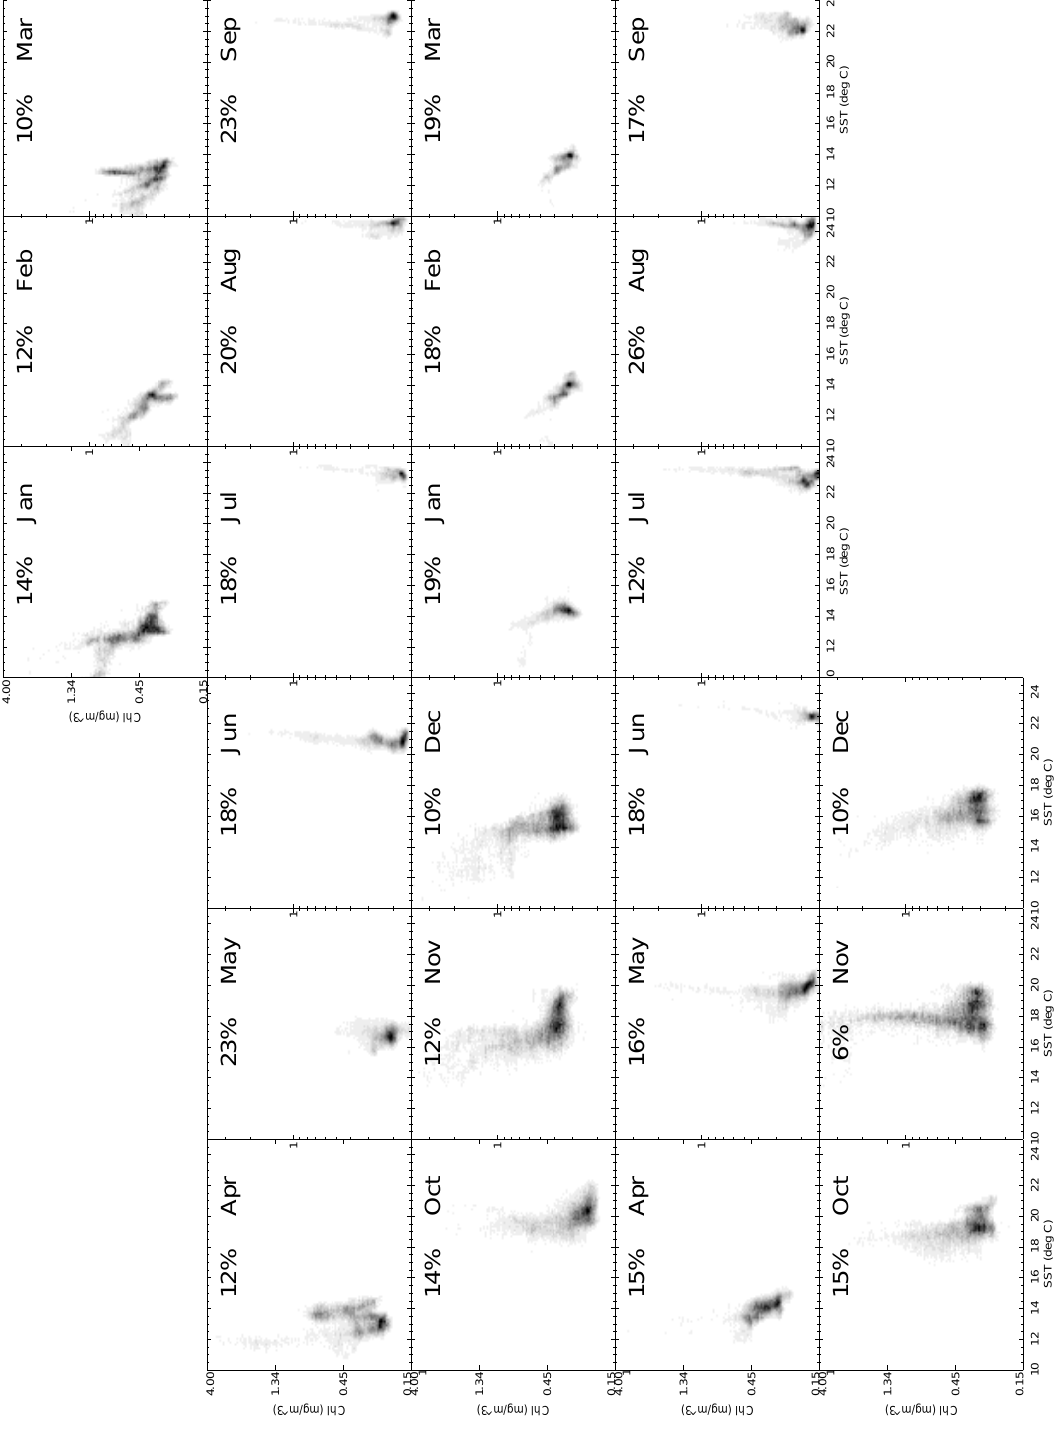
Fig. 4b. Chl-SST histograms for the same months shown in Fig. 4a. For each month the surface area occupied by MW is indicated as percent of the